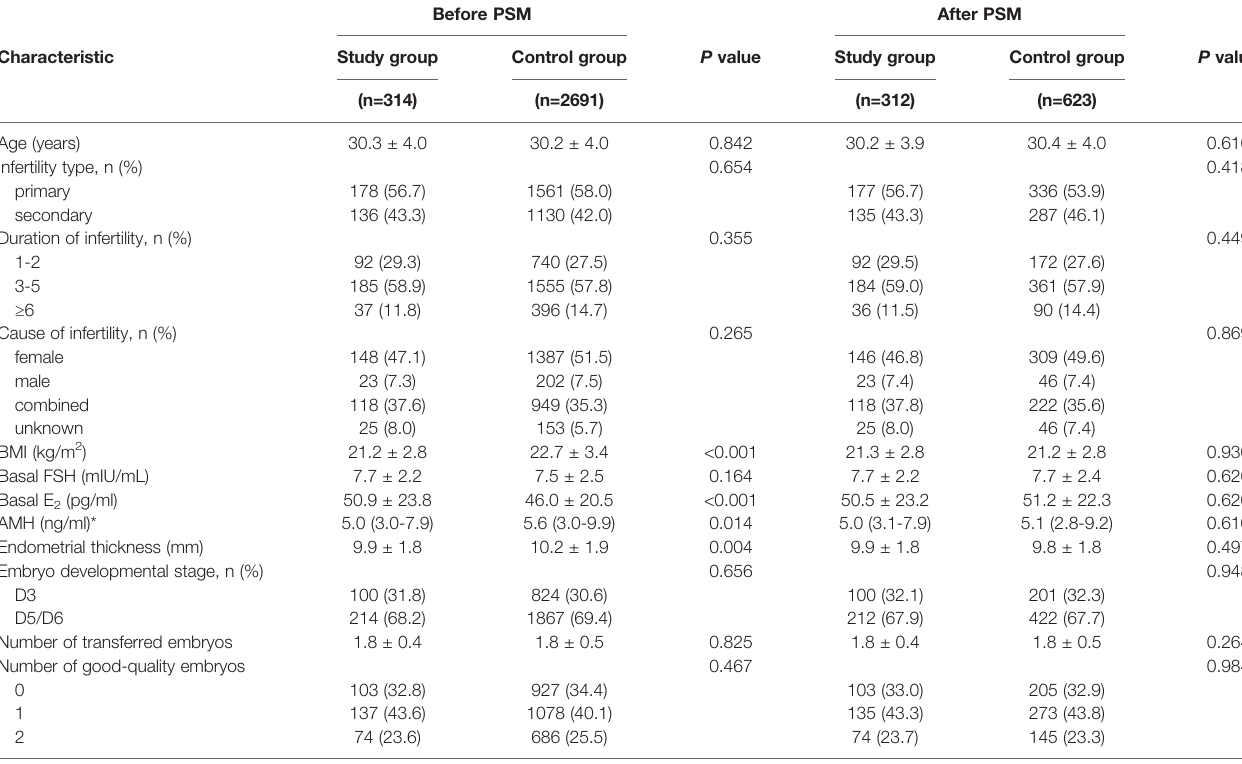
TABLE 1 | Demographic characteristics before and after propensity score matching.